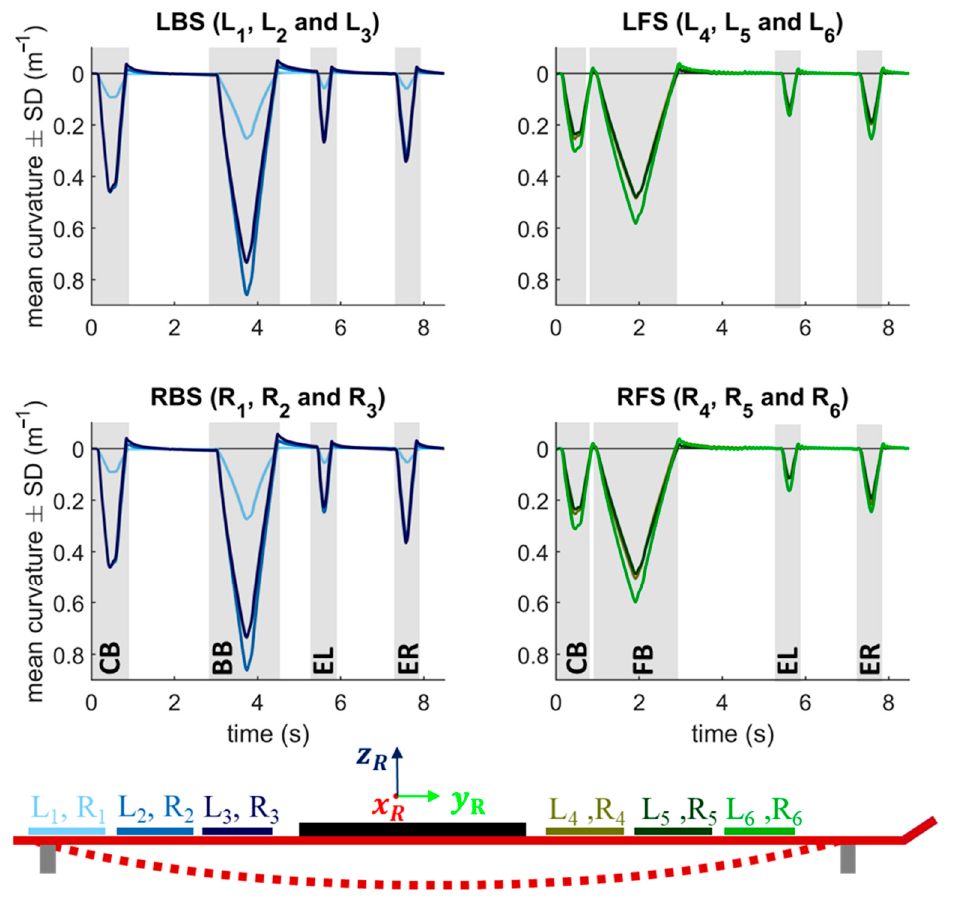
Figure 5. The PyzoFlex ® sensor signals (mean +/ − standard deviation (SD)) over 20 cycles during dynamic loading with v fast . The rear sensors (R 1 , R 2 , R 3 , L 1 , L 2 , and L 3 ) are shown in blue and the front sensors (R 4 , R 5 , R 6 , L 4 , L 5 , and L 6 ) in green. The ski was deformed with a bending robot through five deformation modes (CB: central bend; FB: front bend; BB: rear bend; EL: edge left; ER: edge right). Table 1. Analysis of instrument reliability from the sensor